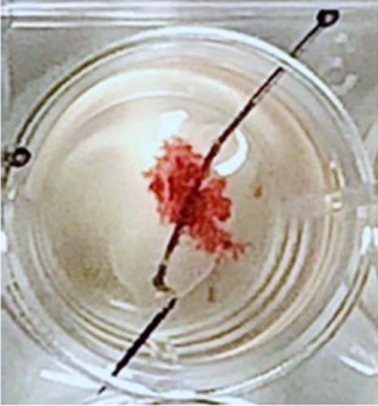
Figure 2. Chorionic villous explants on a needle. Chorionic villous explants are obtained after dissection of a human placenta at term or from the first trimester of pregnancy. The villous explants are kept in suspension in the culture medium as hanging villi after having been threaded on a